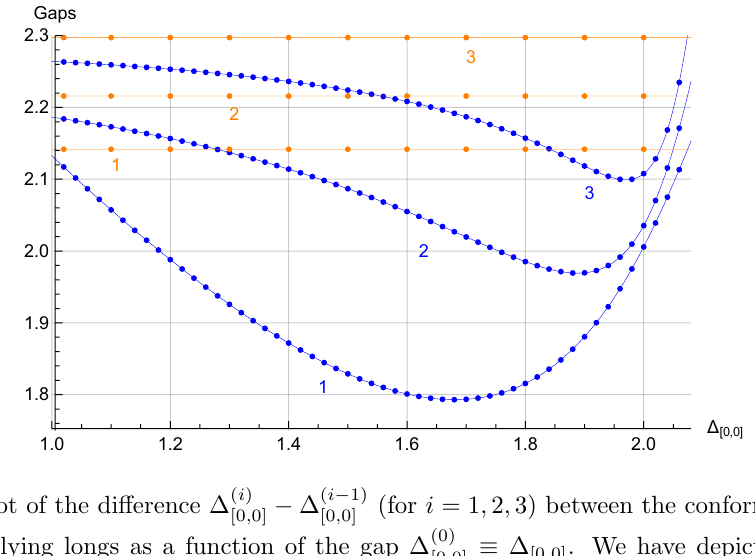
Figure 7 . Plot of the di(cid:11)erence (cid:1) ( i ) of the lowest lying longs as a function of the gap (cid:1) (0) spectrum of for the lower bound and in orange the spectrum of the upper bound with the numerics done for (cid:3) = 80. Observe that the upper bound spectrum is independent of (cid:1) become identical for the maximal value of (cid:1)